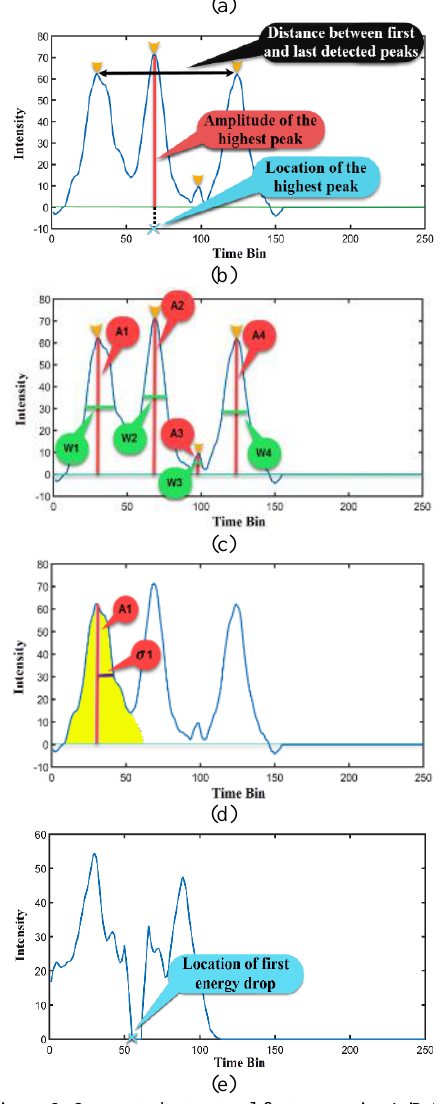
Figure 3. Generated structural features using LiDAR waveforms.